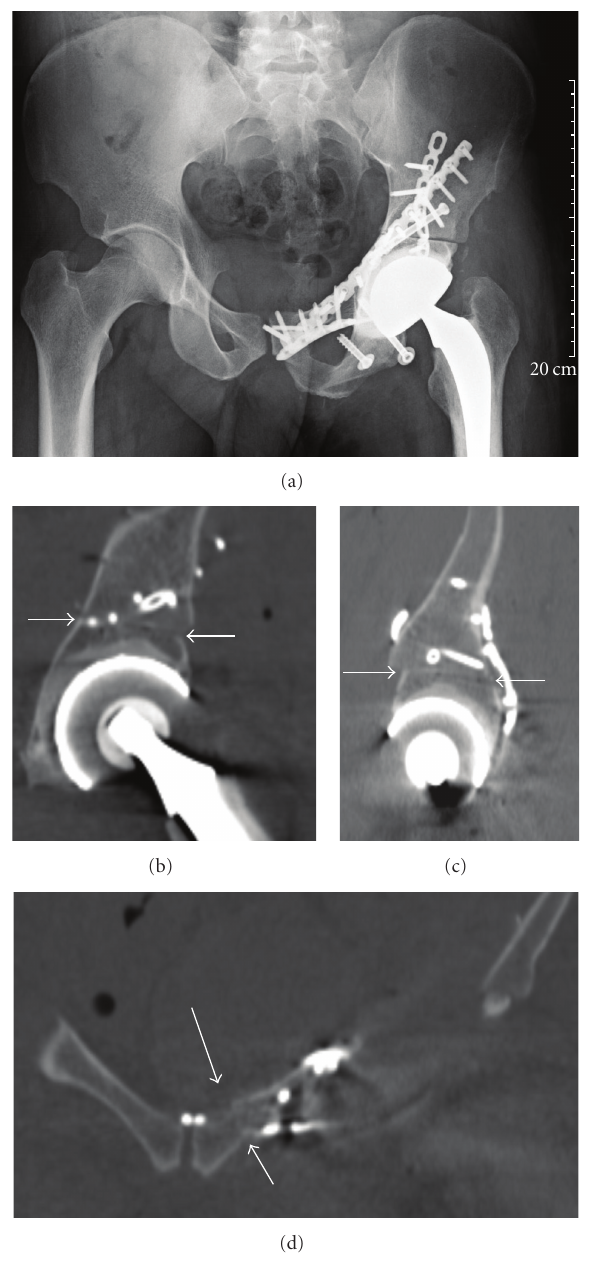
Figure 4: (a) Postoperative radiograph of the pelvis showing the reconstruction. (b) CT with coronal reconstruction showing the host-graft junction (white arrows) in the supraacetabular area. (c) Sagittal reconstruction of the supraacetabular junction (white arrows). (d) Coronal reconstruction of the pubic junction (white